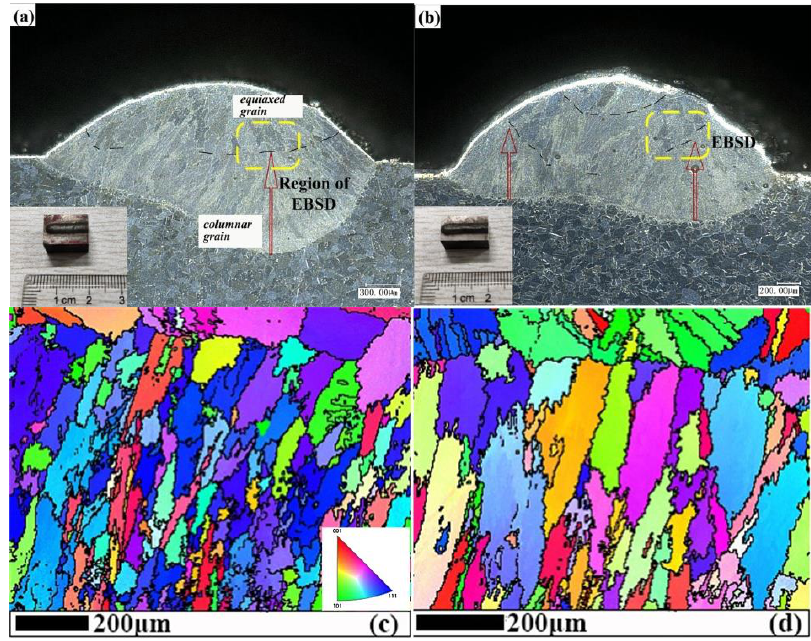
Figure 18. Cross section of cladding layer: ( a ) additional water cooling device (7.5 L/min), ( b ) air cooling, ( c ) EBSD map of ( a ), ( d ) EBSD map of ( b ). As shown in Figure 19, the middle of the cladding layer was selected as the columnar dendrite observation area, and the primary dendrite arm spacing (PDS) was measured by Image-J software. Primary dendrite arm spacing is measured by dividing the distance between dendrite gaps by the number of dendrites. The average value was obtained by multiple measurements, and multiple regions were selected for repeated operation to measure the primary dendrite arm spacing. The results are shown in Figure 20. It can be found that the primary dendrite arm spacing decreases with the increase of cooling rate. Compared with the four processing conditions, the maximum cooling rate is provided by reducing the power water cooling (7.5 L/min) condition, and the primary dendrite arm spacing can reach about 8.3 μm . The minimum cooling rate is provided by constant laser power air cooling, and the primary dendrite arm spacing reaches about 11.02 μm.